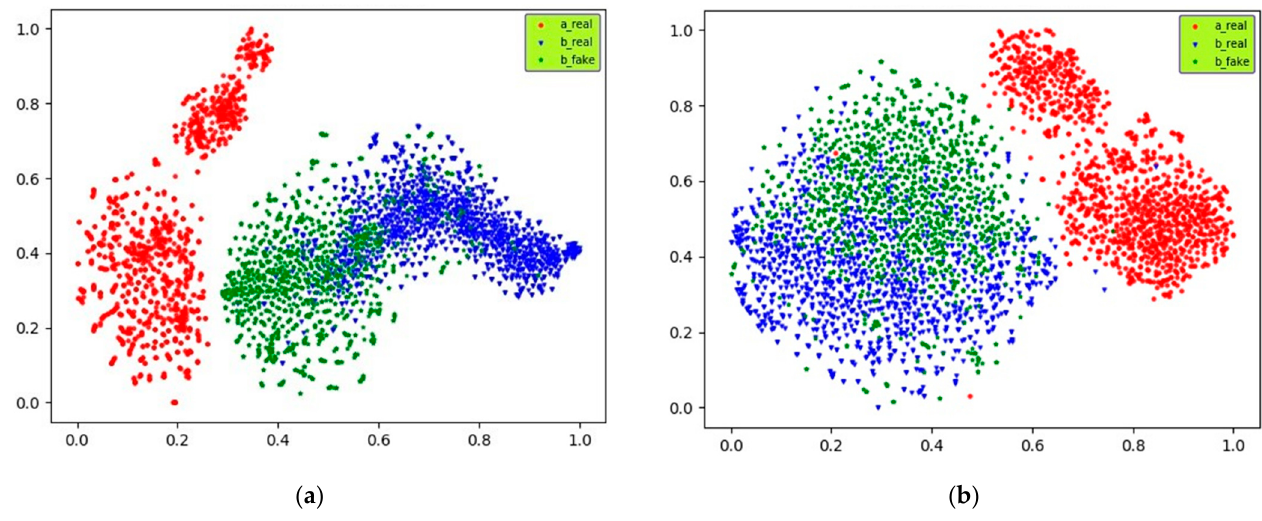
Figure 7. Feature distribution results. ( a ) represents the feature distribution results of the images input into the discriminator (D) network, and ( b ) displays the feature distribution results of the images input into the ResNet-50 network. Since D has the discriminant effect, while ResNet-50does not have, so b_real and b_fake are closer in the feature